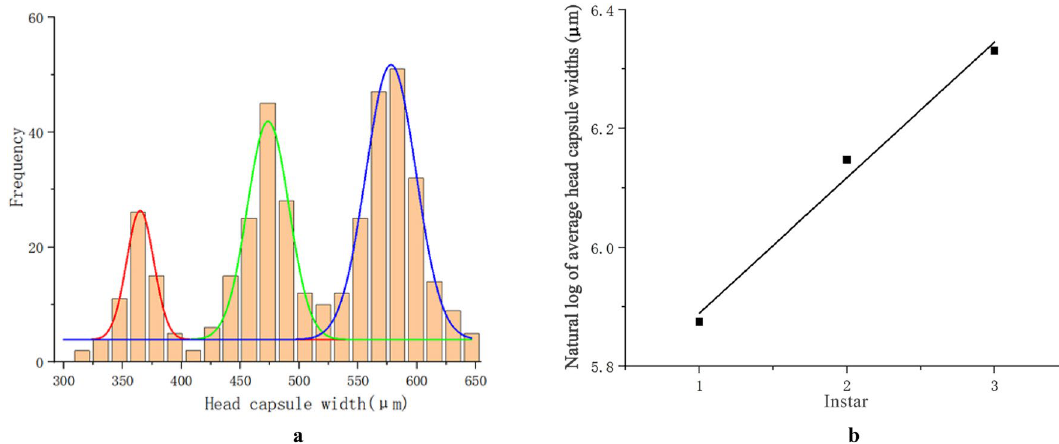
Figure 8. Determination of larval instars of Rhynchaenus maculosus . ( a ) Frequency distribution histogram of head capsule width in different larval instars; ( b ) Linear regression between the natural logarithms of average head capsule widths and larval instars.